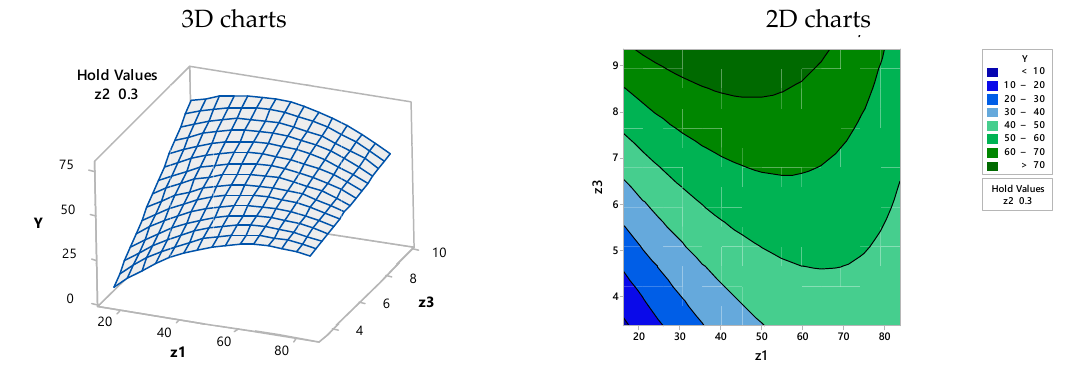
Figure 4. Surface plot ( left ) and contour plot ( right )—efficiency (Y) vs. biosorbent concentration (Z 1 ) and biosorption contact time (Z 3 ) at a constant BRed dye concentration (Z 2 = 0.3 mg/L).